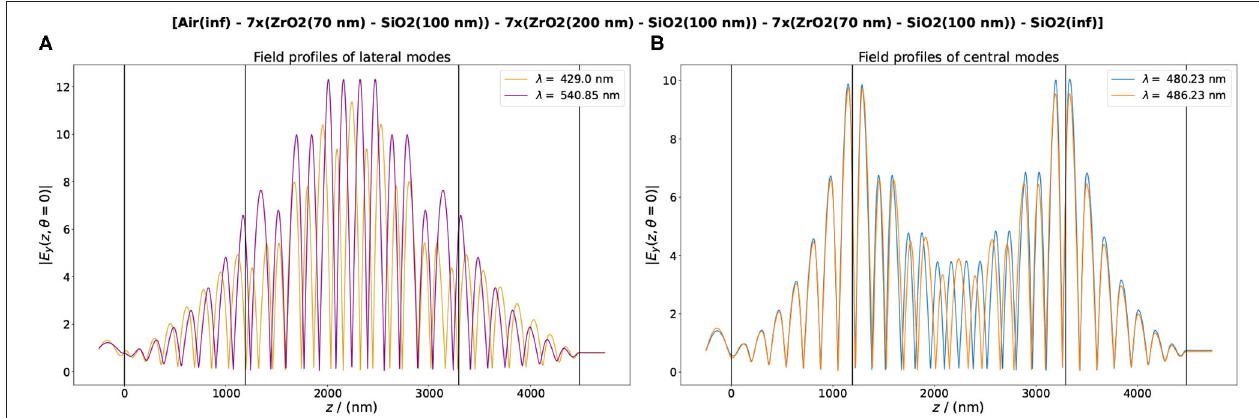
E y ( λ i , z ) FIGURE 13 | Profiles of for the 4 narrow bands in the bandgap. The central OTS have maxima at the boundaries of the photonic crystals and decay in booth | | directions with the distance. Their profiles are almost symmetric and overlap in the both external PCs, but not in the central PC2. The profiles of the lateral modes have maxima localized in the central PC2 and decay in both directions. Profiles of the modulus of the electric field along the propagation axis for the lateral modes (A) and central modes (optical Tamm states) (B) .